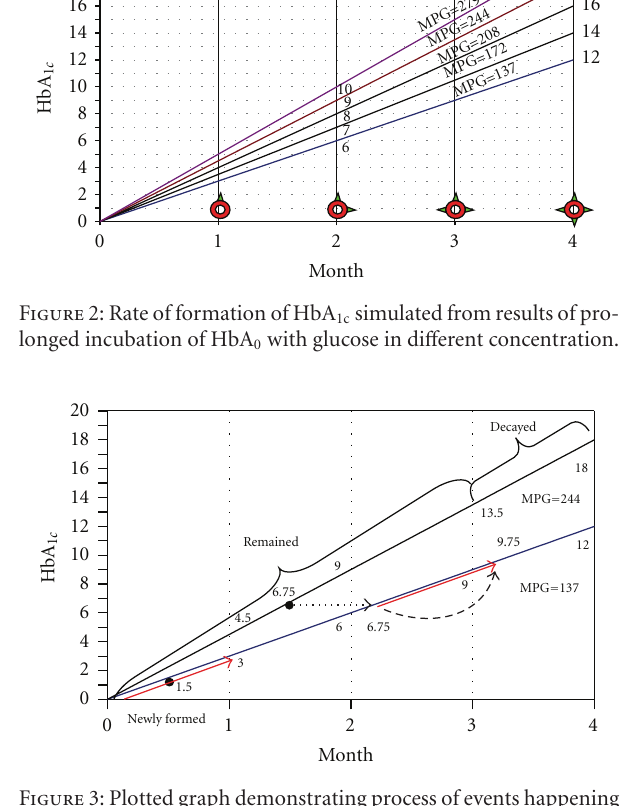
Figure 3: Plotted graph demonstrating process of events happening in the hypothetical Example